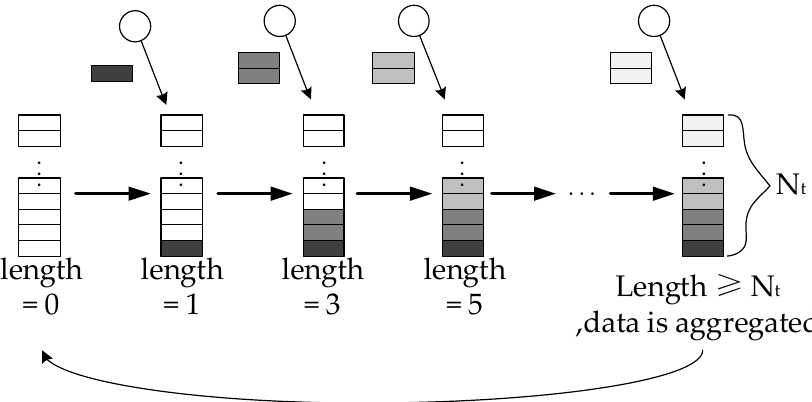
Figure 3. Packet aggregation occurs since the length of packet queue is equal to or greater than N t . Definition 4. Value of the Packet Aggregation Timer.